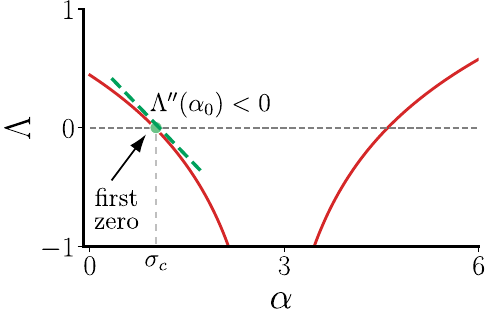
Fig. 1 Curvature of the master stability function at its fi rst zero. Example master stability function for which temporal networks can synchronize stably below the critical coupling strength σ c